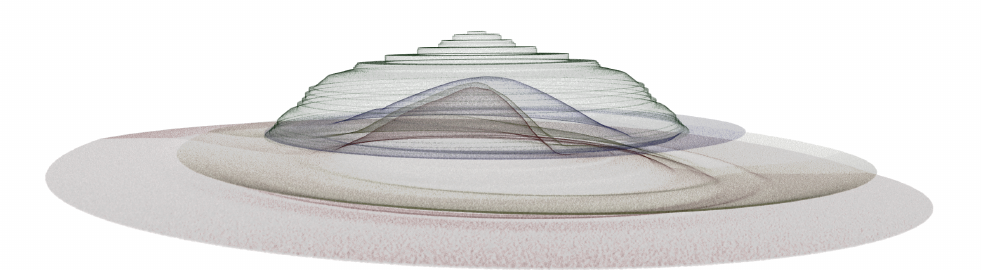
Figure 15. The fused transparent results of the reconstructed points of the four foundation layers of the unreachable foundation.